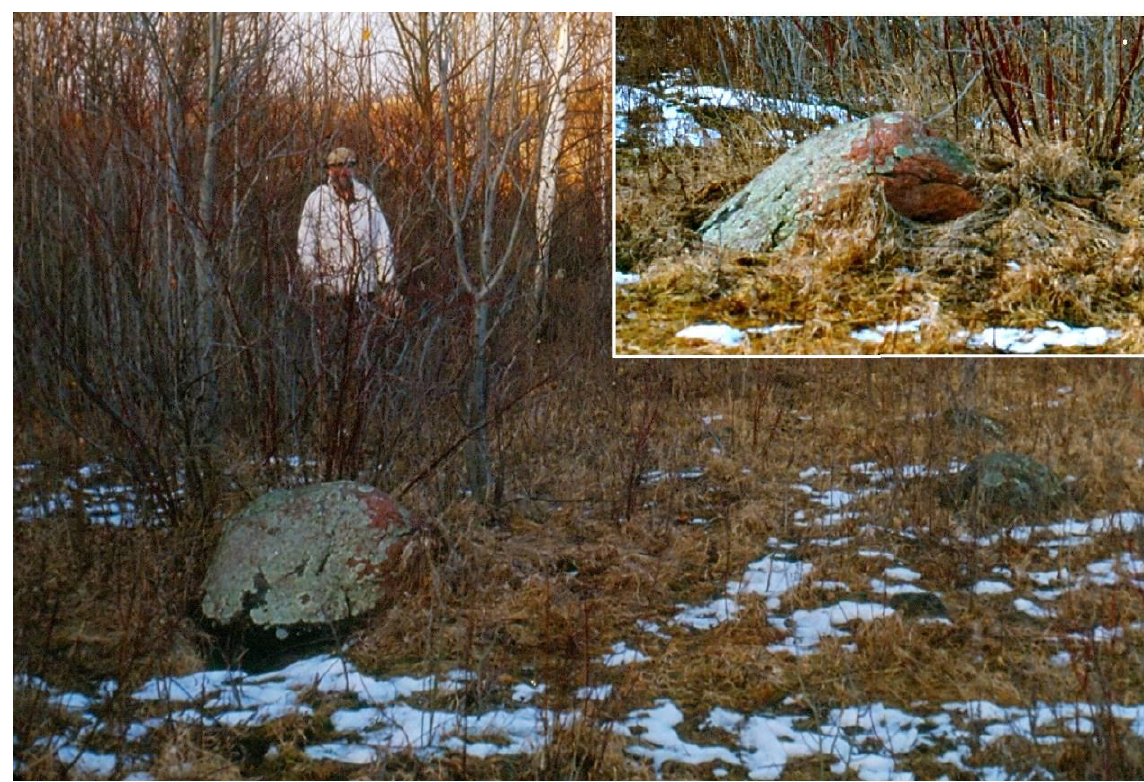
Figure 6. The metre or waist high, triangular-shaped, red rhyolite porphyry rock (now tipped) which once stood on an earthen mound surrounded by a circle of rocks partially visible in the photo.